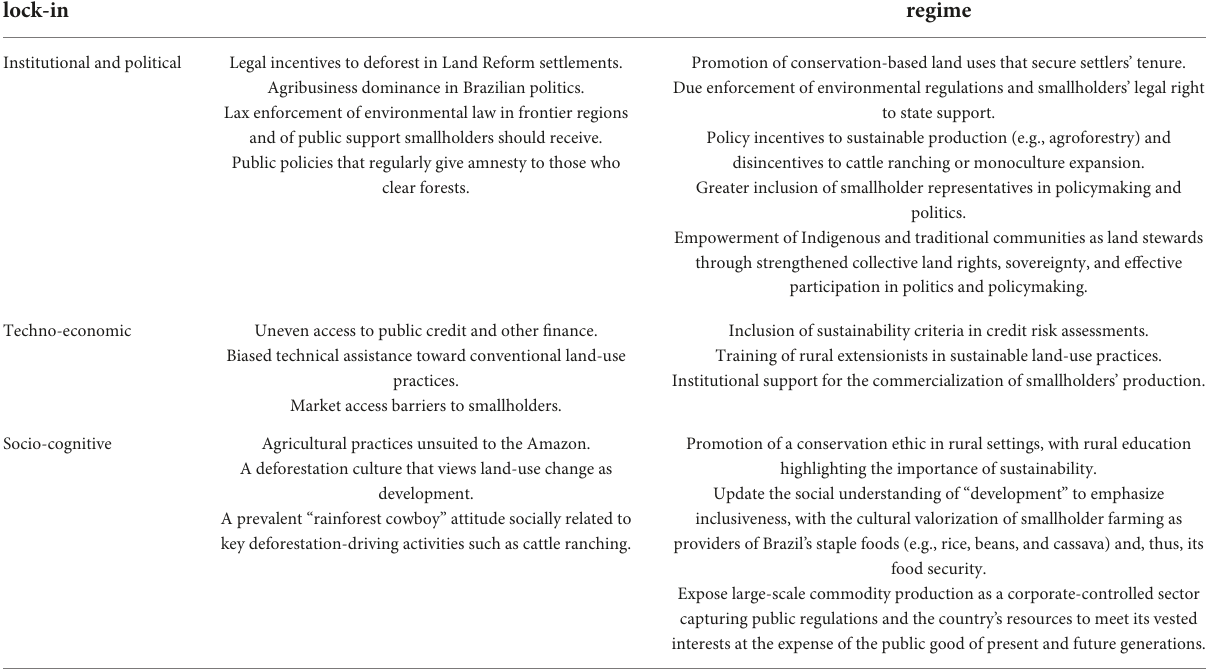
TABLE 3 AS forms of deforestation lock-in in Land Reform settlements of the Brazilian Amazon. Deforestation